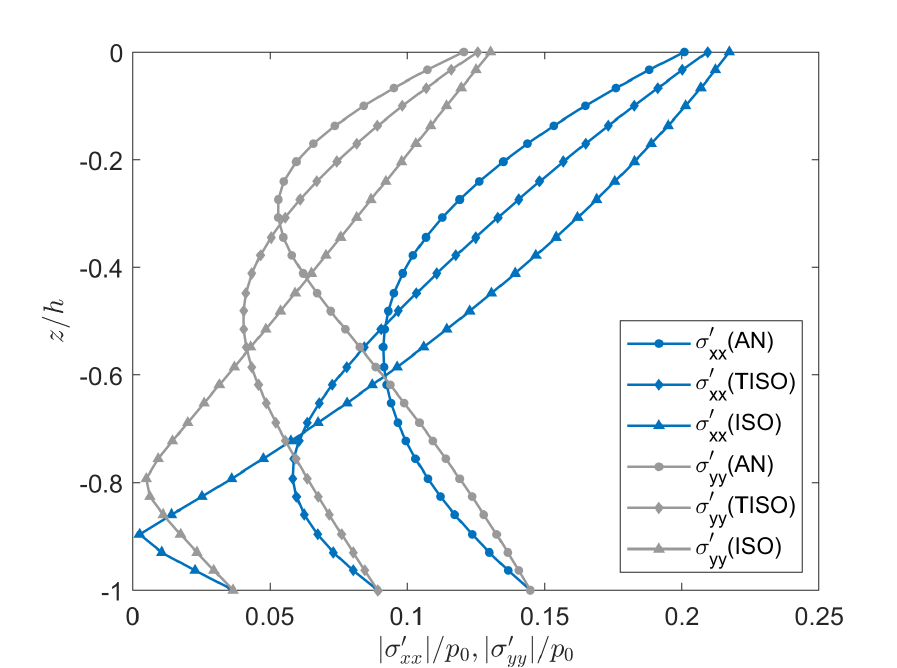
Figure 6. Comparison of horizontal effective stresses σ (cid:48) xx and σ (cid:48) yy for AN, TISO, and ISO permeabilities (AN, TISO, and ISO correspond respectively to Cases 2, 8, and